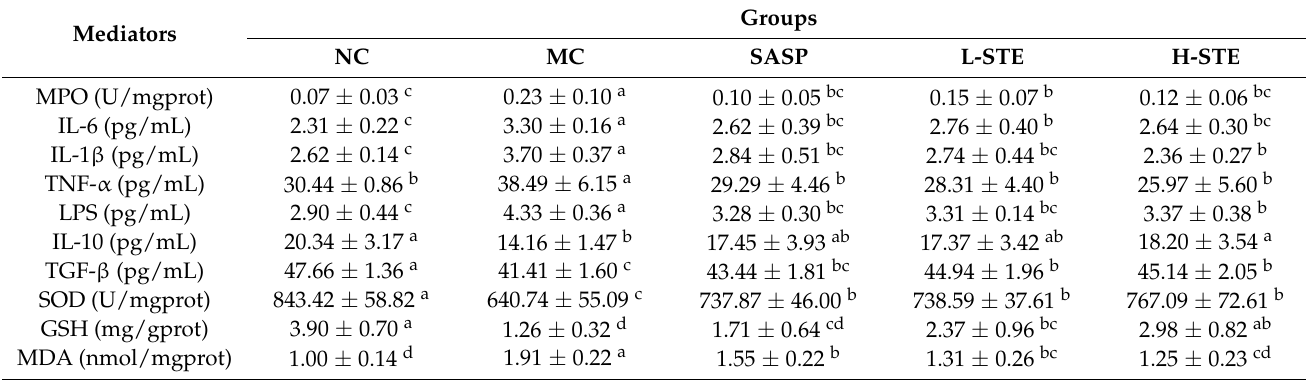
Table 1. Effects of STE on the inflammatory and oxidative-related mediators.